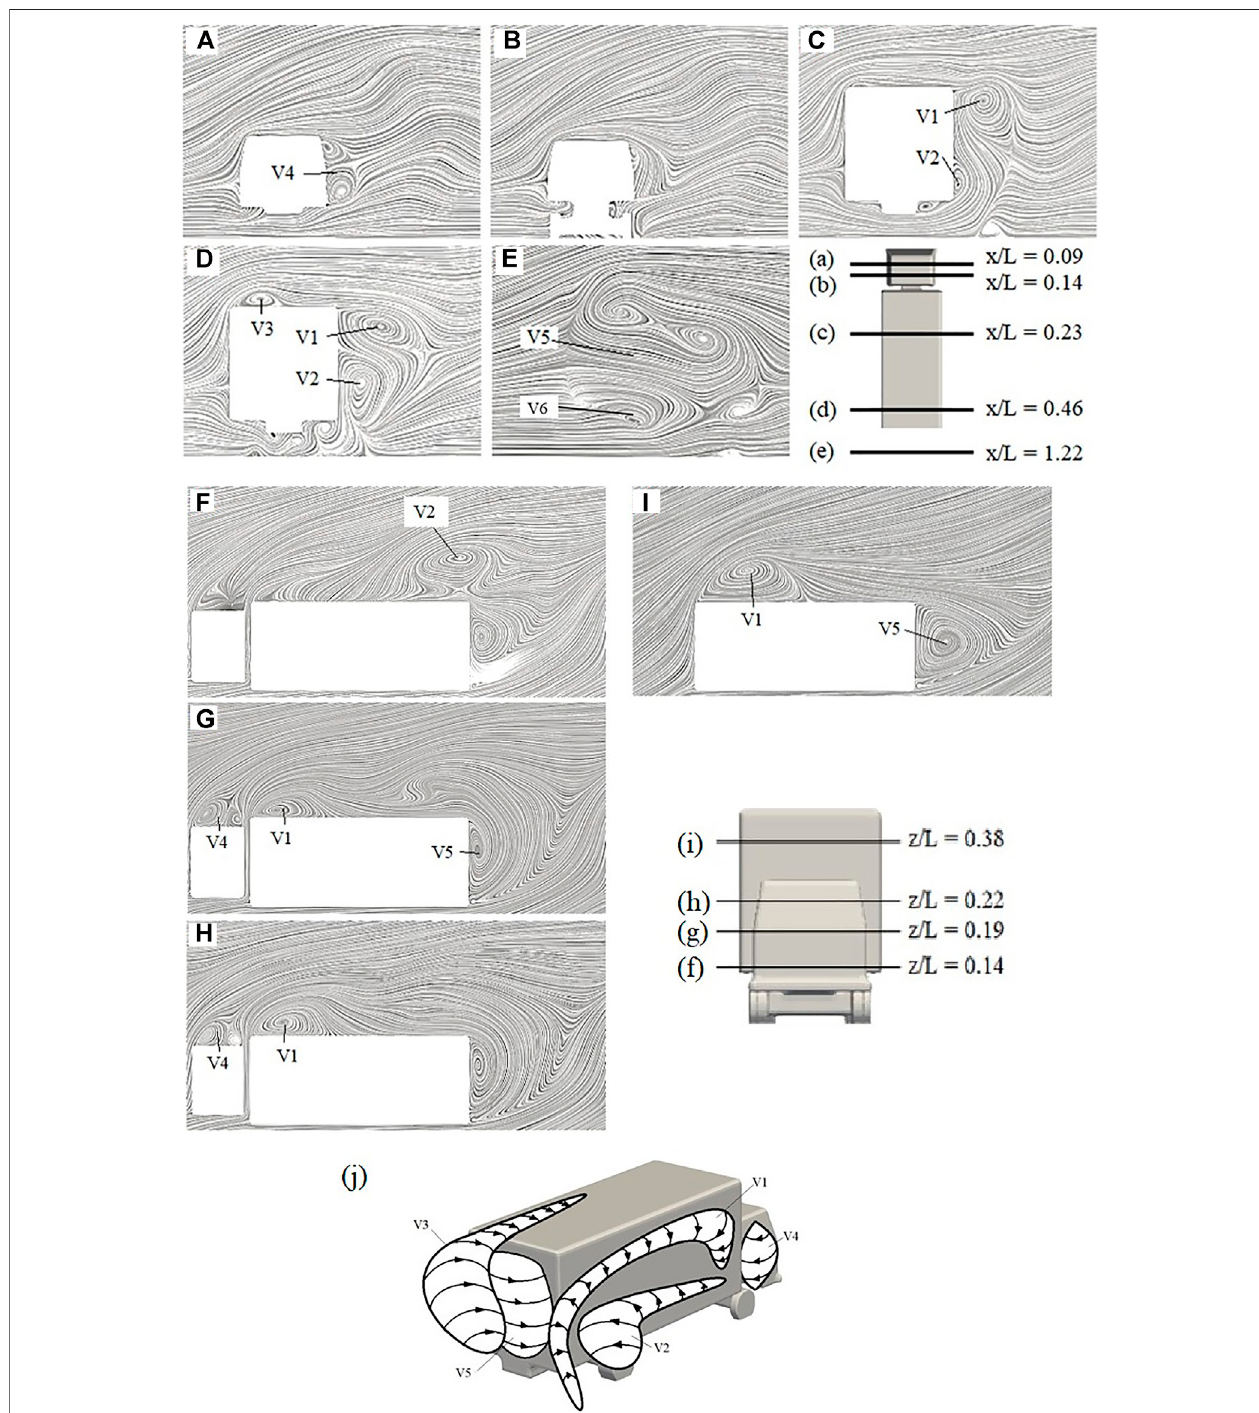
FIGURE 12 | Time-averaged streamlines projected on cross sections normal to x -axis at different longitudinal positions, (A) , (B) , (C) , (D) , and (E) . Time-averaged streamlines projected cross sections parallel to the ground of the lorry at a different height (F) , (G) , (H) , and (I) (J) Schematic illustration of the time-averaged fl ow topology around lorry one in the